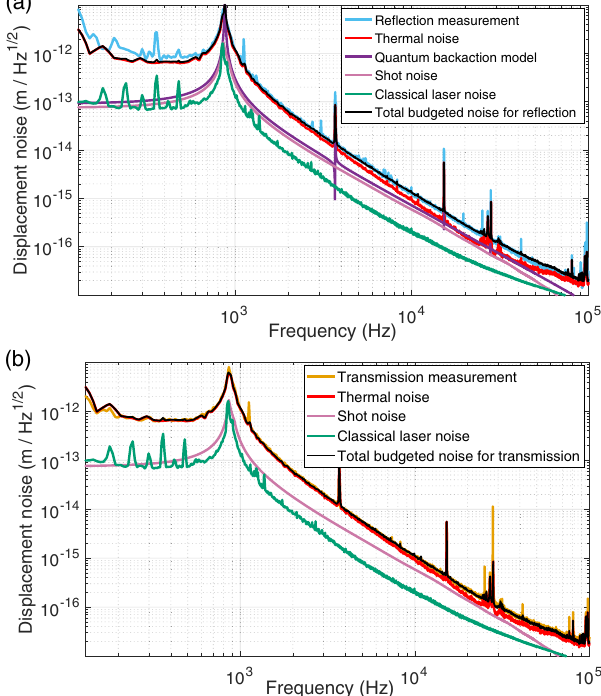
FIG. 3. Measured and budgeted displacement noise spectra taken in reflection (a) and transmission (b) of the cavity. The individual noise sources for each measurement are added in quadrature to calculate the total budgeted noise. The coupling of the higher order mechanical modes of the microresonator are reduced with respect to their magnitudes in Ref. [12] as a result in improvements in our ability to align the optical beam onto the nodal points of those